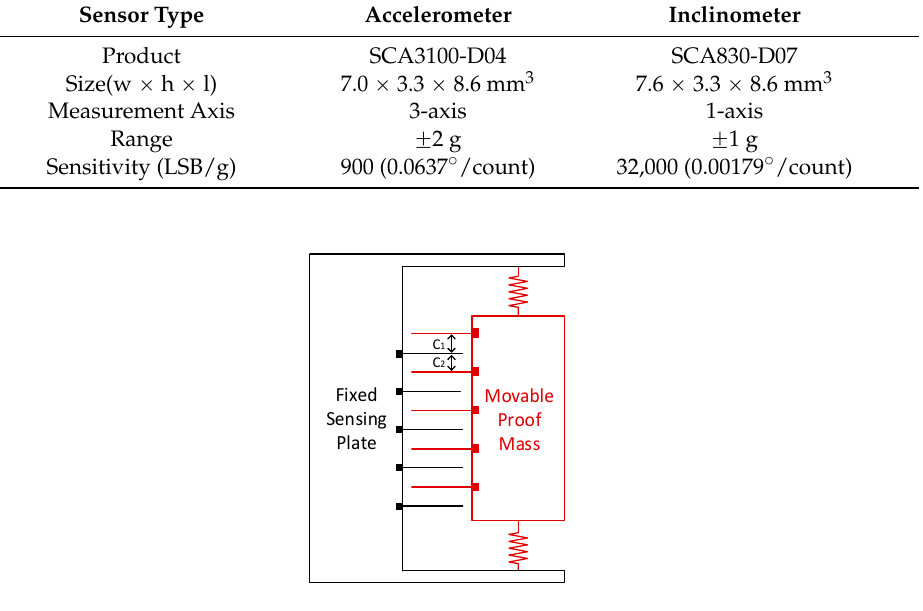
Figure 2. Sketch of a MEMS Accelerometer (Modified from [14]). The sensing plate is fixed onto the sensor board and the movable proof mass is suspended by the restoring spring. The proof mass will drift downward when a linear acceleration points upwards or the Earth’s gravitational field points downwards.